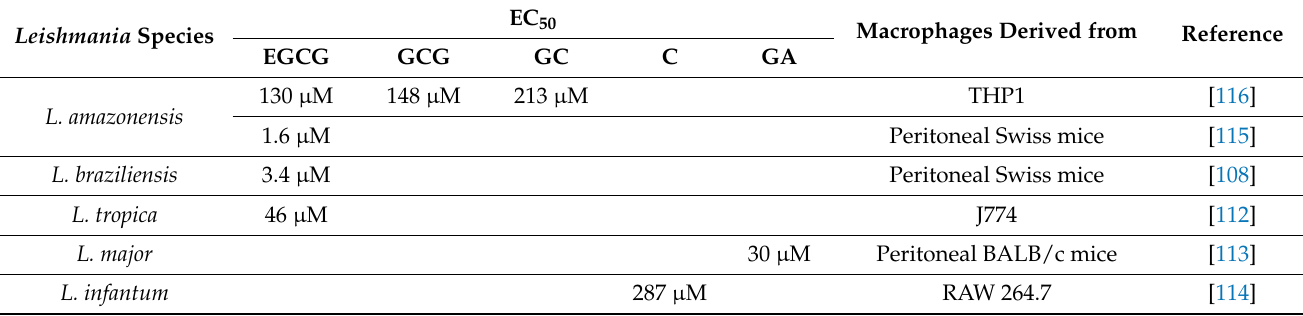
Table 7. In vitro activity of green tea polyphenols against intracellular